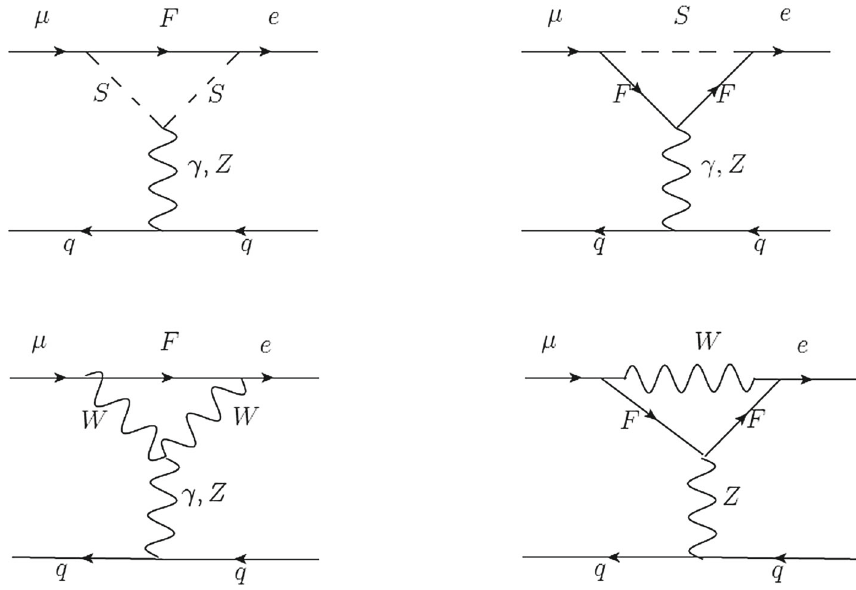
Fig. 1 The penguin diagrams for μ → e + q ¯ q, with F representing Dirac(Majorana)